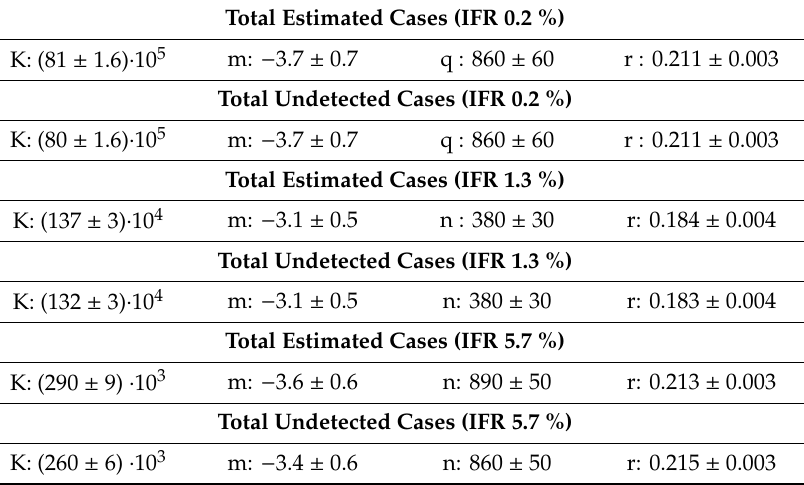
− xr ) parameters for the estimated (total and undetected) COVID-19 Table 2. Logistic fit ( y = K 1 + me 1 + ne − xr cases in Italy based on three di ff erent IFR hypotheses: 0.2% (blue and light blue dots), 1.3% (red and pink dots), and 5.7% (green and light green dots) (see Figure